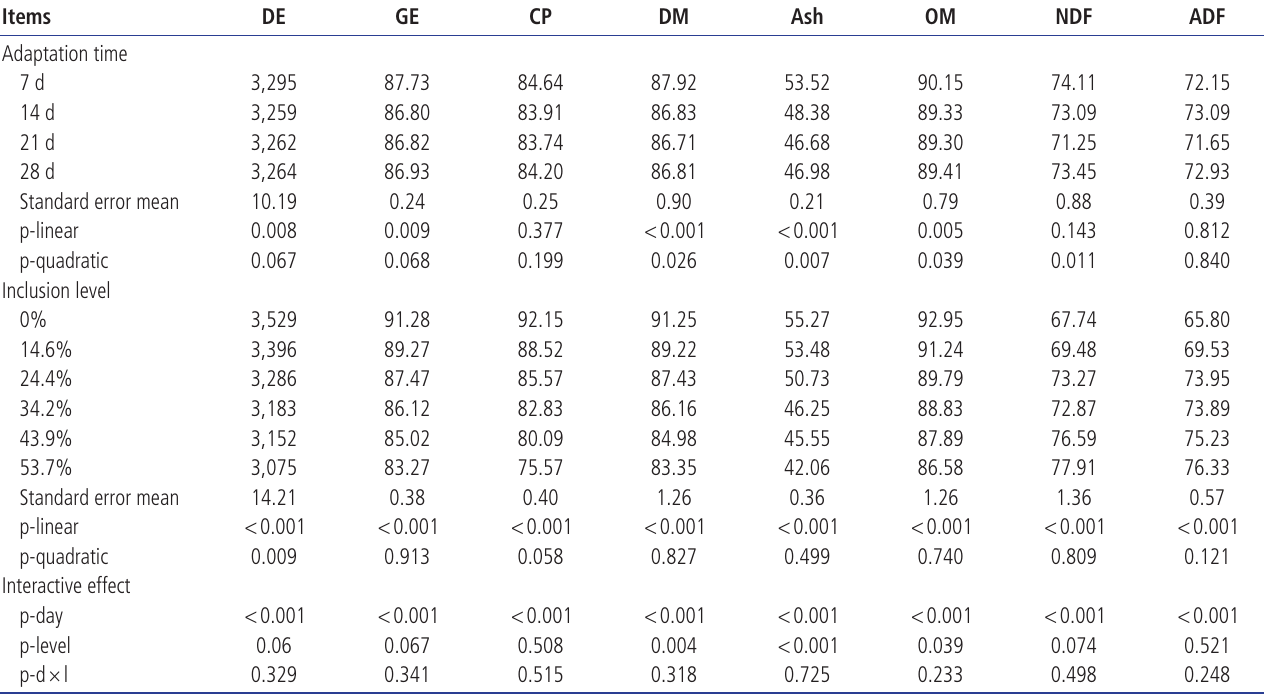
Table 4. The effect of adaptation time and inclusion level of sugar beet pulp on digestible energy (DE, kcal/kg, as-fed basis) value and nutrient digestibility (%) of experimental diets fed to pigs in Exp. 1 1)